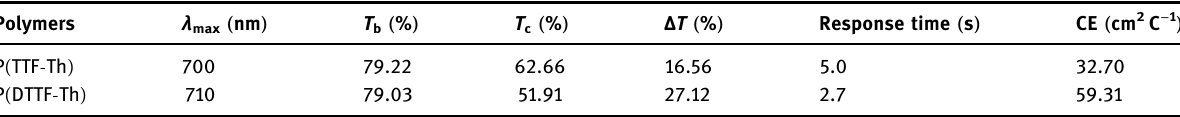
Table 2: Electrochromic performance parameters of two polymers